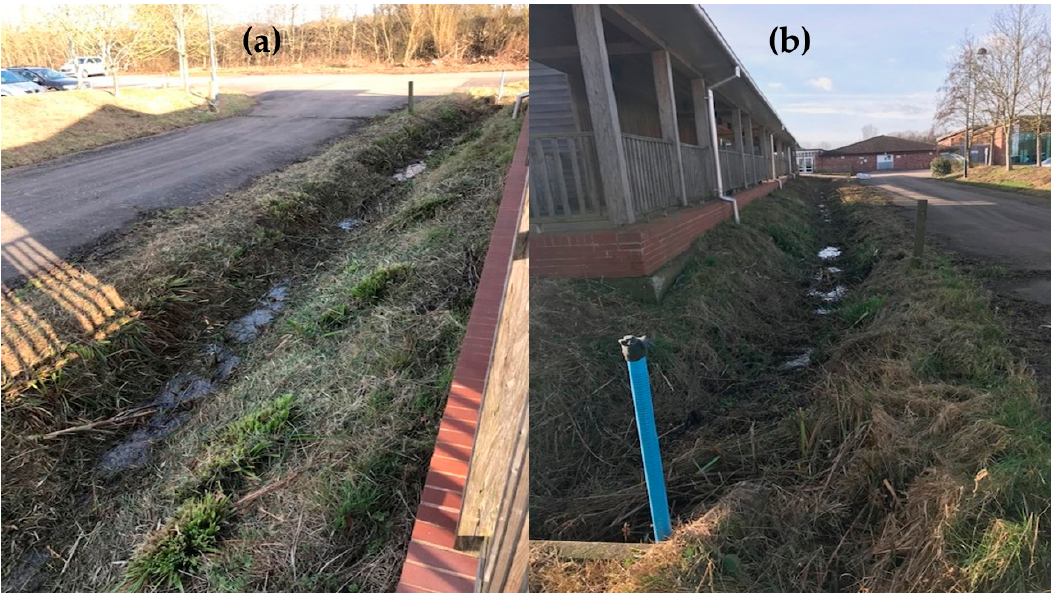
Figure 5. Detail of the swale after complete removal of vegetation (February 2020): ( a ) South-west sight of the swale; ( b ) North-east view of the swale from the discharge point and the monitoring device.